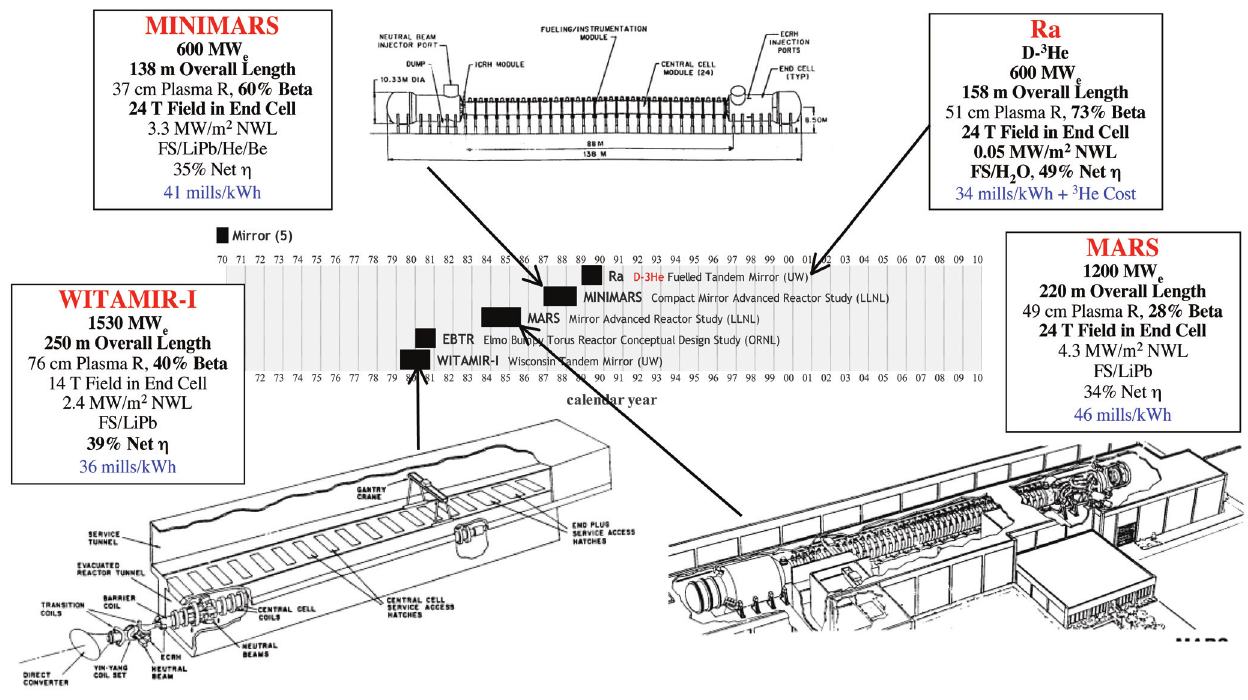
Figure 6. Timeline and main features of tandem mirror power plant